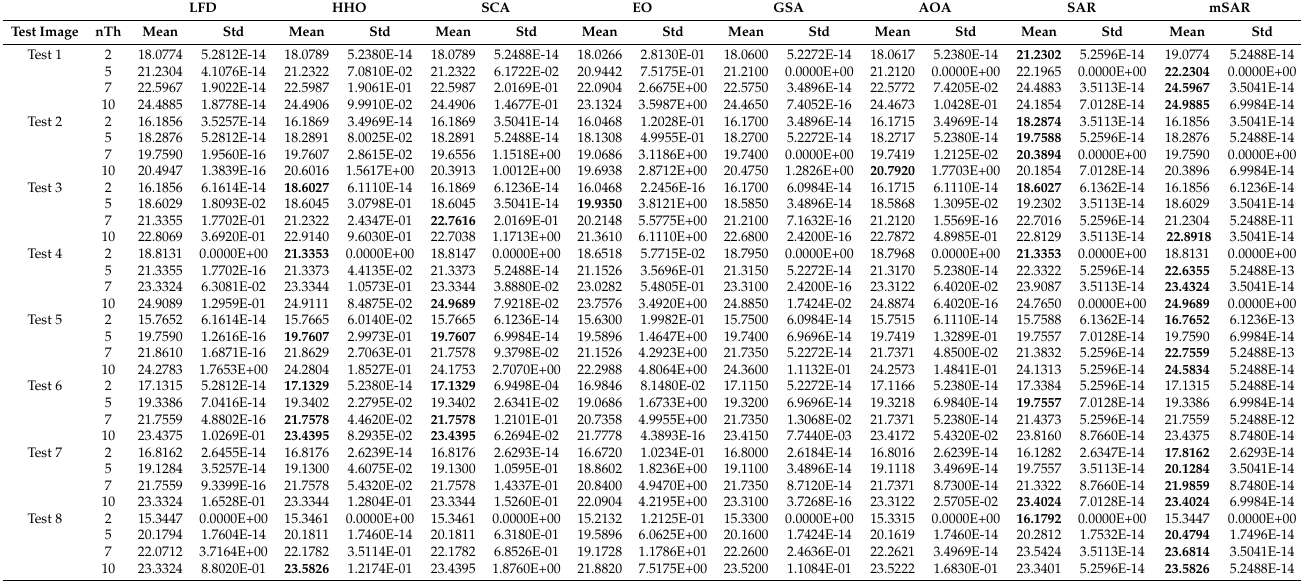
Table 9. mSAR Otsu in terms of PSNR values competed overall for